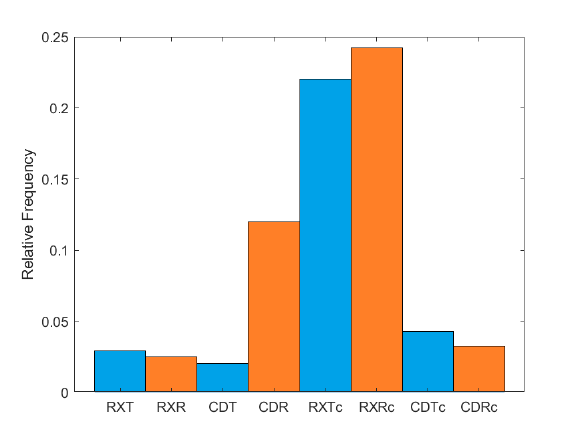
Figure 6. Area 2: Relative frequencies of anomalies. RXT: RX-Detector applied on the determined temperatures. RXR: RX-Detector applied on the LWIR image. CDT: change detection between the determined and simulated temperatures. CDR: change detection between the given and simulated LWIR image. RXTc, RXRc, CDTc, CDRc: as before, but with each class considered separately and finally merged.